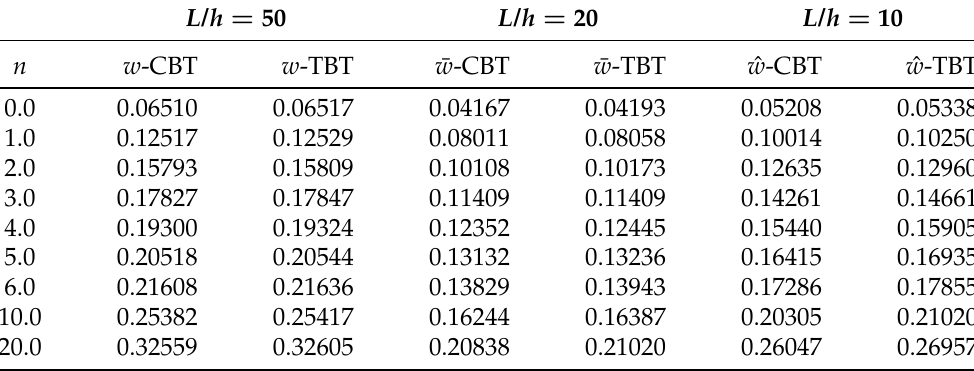
Table 2. Numerical results obtained with the classical (CBT) and the Timoshenko (TBT) beam theories for the transverse deflections of a pinned–pinned FGM beams under a uniformly distributed load (the results are normalized with the load, q 0 ); ¯ w = w ( 0.5 L ) 10 and ˆ w = w ( 0.5 L ) × 10 2 . L / h =